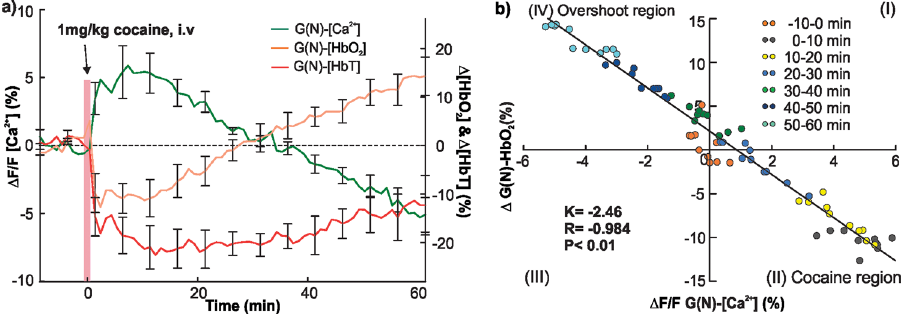
(green), Ca 2 þ - G ð N Þ